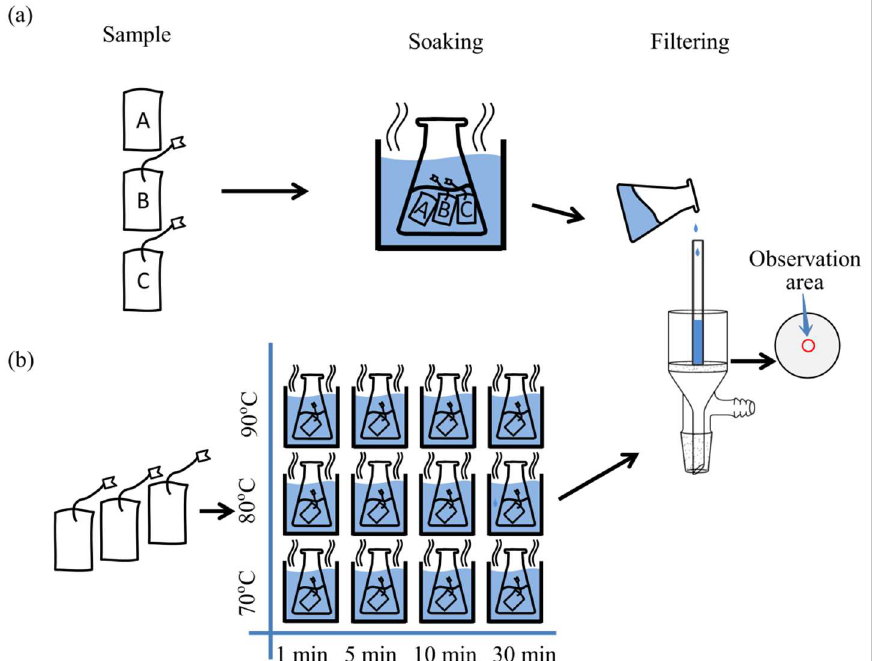
Figure 1. Sample preparation process for ( a ) optimization of peak area imaging for various MPs and ( b ) simultaneous identification of various MPs released from filter bags. A, B, and C in ( a ) represent sample A, sample B, and sample C, respectively.